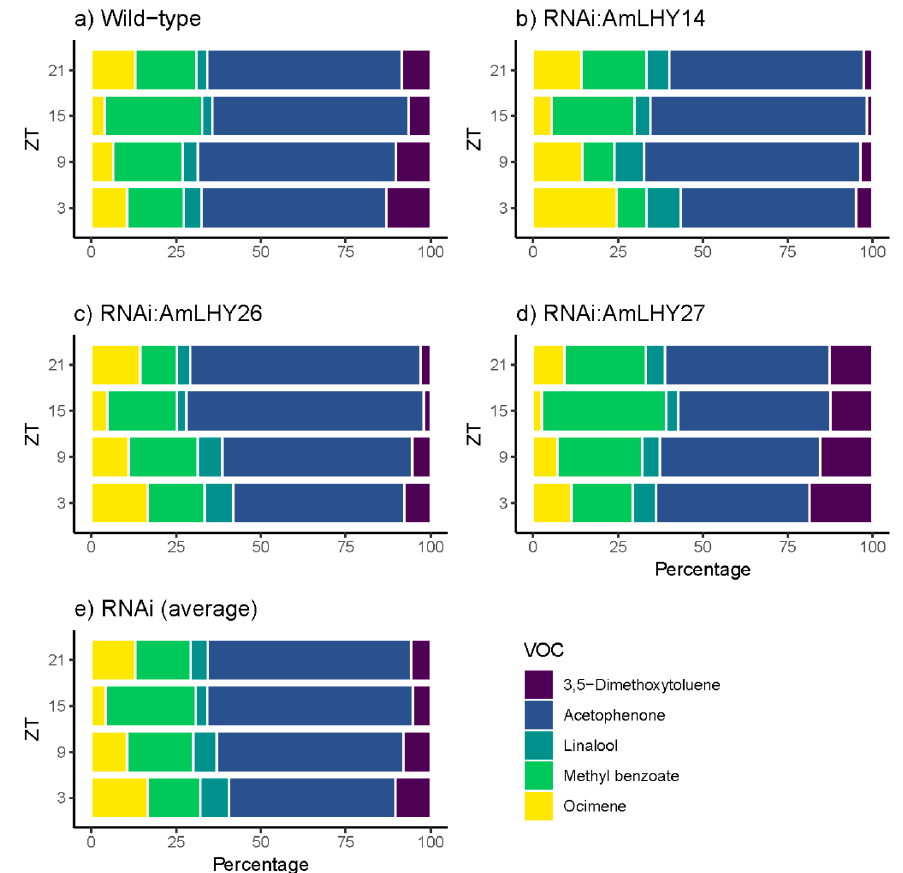
Figure3. Dailyscentemissionofmajorcompoundsinwildtype( a ), andtransgeniclines RNAi:AmLHY14 ( b ), RNAi:AmLHY26 ( c ), RNAi:AmLHY27 ( d ). An average of RNAi lines is represented in ( e ). ZT indicates zeitgeber